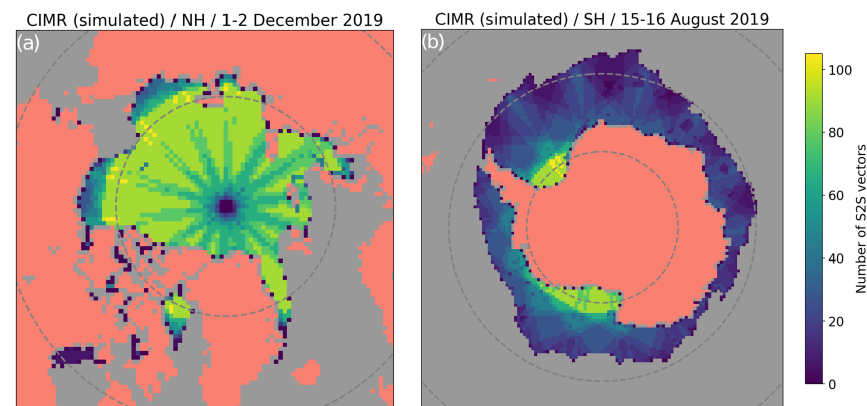
Figure 10. Same as Fig. 3 but for simulated CIMR coverage. (a) Number of S2S vectors per grid cell in the Northern Hemisphere with the same sea-ice cover as 1–2 December 2019. (b) Number of S2S vectors per grid cell in the Southern Hemisphere and with the same sea-ice cover as 15–16 August 2019. Parallels at ± 75 and ± 60 are